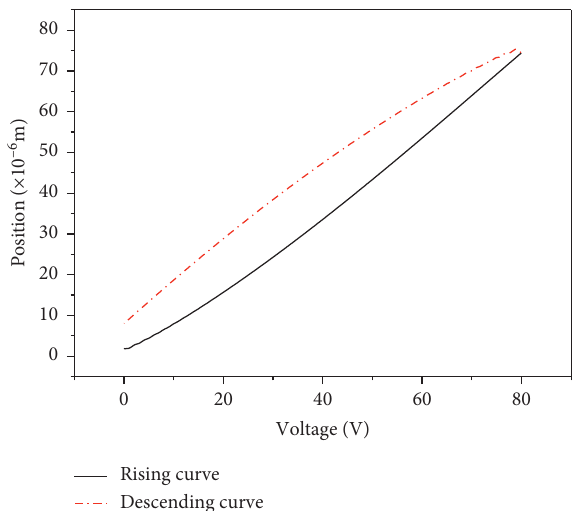
Figure 7: Hysteresis curve of piezoelectric